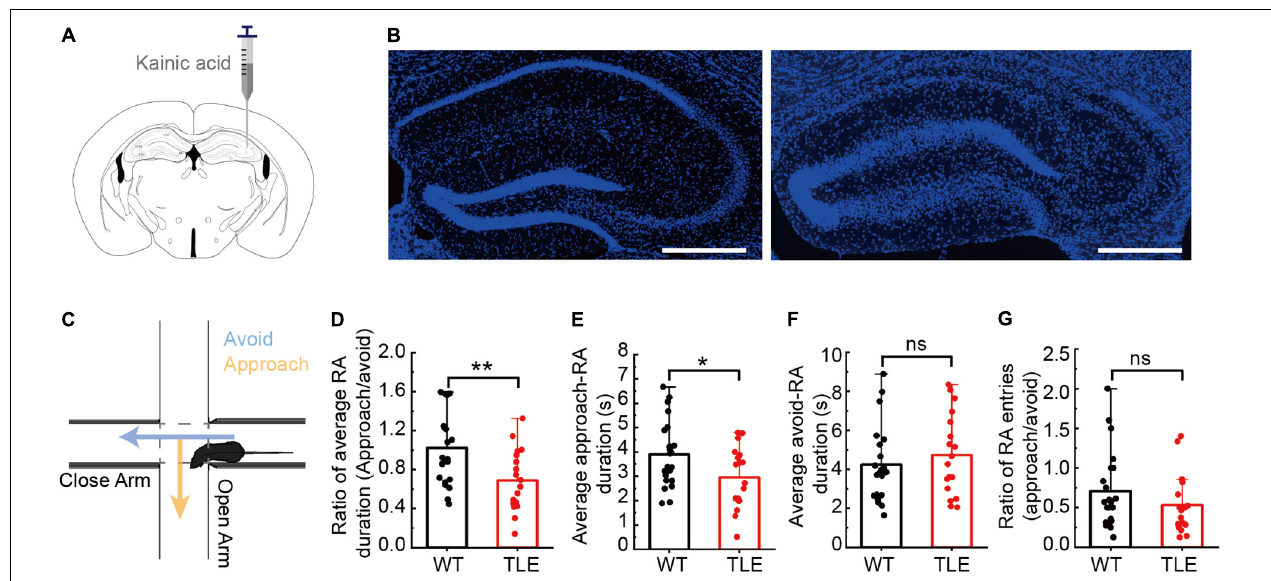
FIGURE 1 | Kainic acid-induced TLE mice showed impairments in the hippocampal cytoarchitecture and RA behavior. (A) Schematic diagram of intrahippocampal kainic acid injection in C57/BL6J mice. (B) Comparison of hippocampal subfields between WT and TLE mice. Scale bar, 500 µ m. (C) Schematic diagram of elevated plus maze test and a typical RA. (D) Ratio between average of approach-RA duration and average of avoid-RA duration. (E) Average of approach-RA duration. (F) Average of avoid-RA duration. (G) Ratio between approach-RA and avoid-RA entries (WT, n = 22; TLE, n = 18; ns is no significant difference; error bars represent s.d; * p < 0.05; ** p < 0.01, t